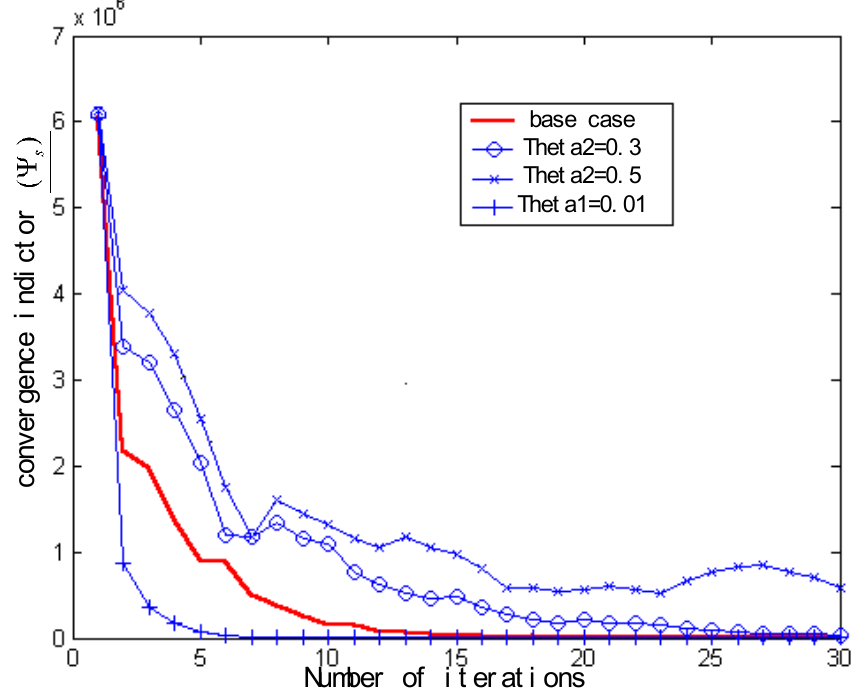
Figure 4. The convergence characteristics of the solution